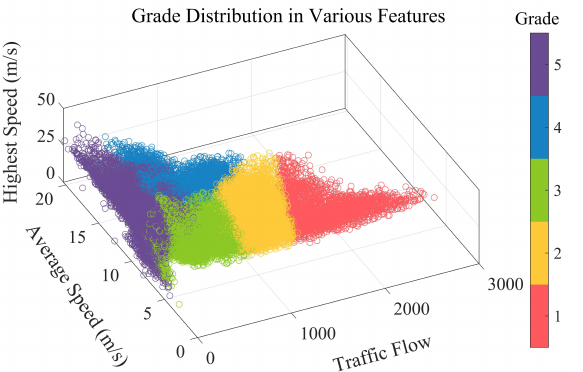
Figure 6. The distribution of five classes in the three dimensions of average speed, average flow, and maximum